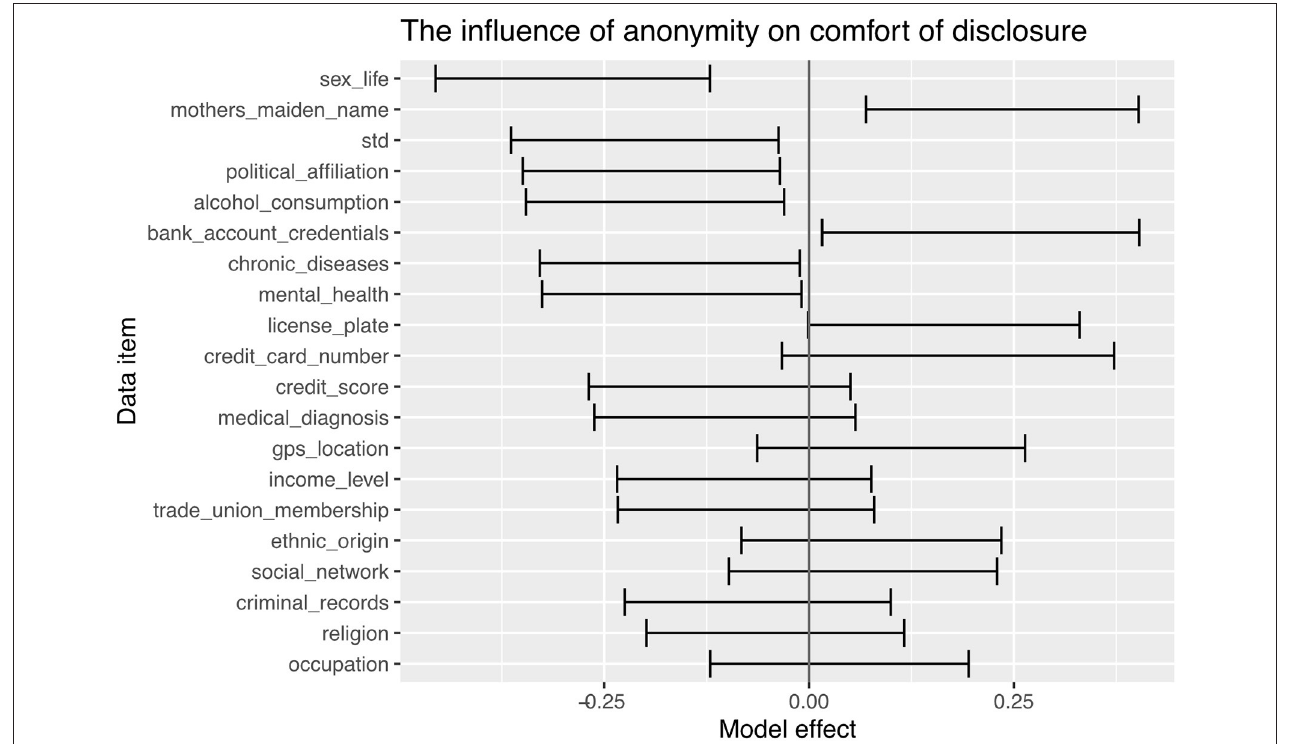
FIGURE 9 | The influence of anonymity on information